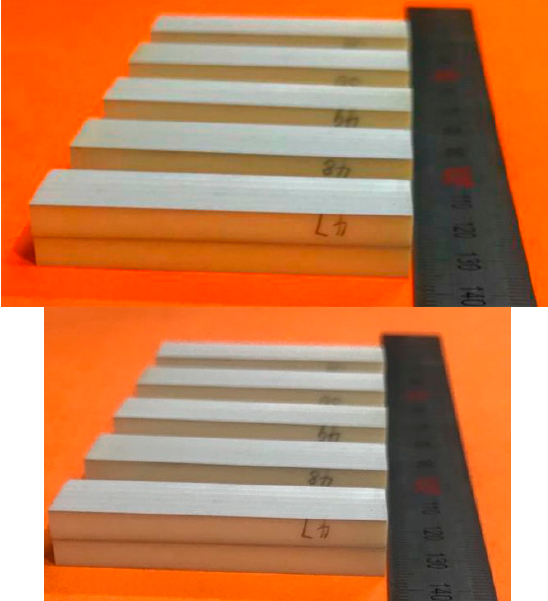
Figure 14. Preparation technology of the piezoelectric ceramic vibrator.